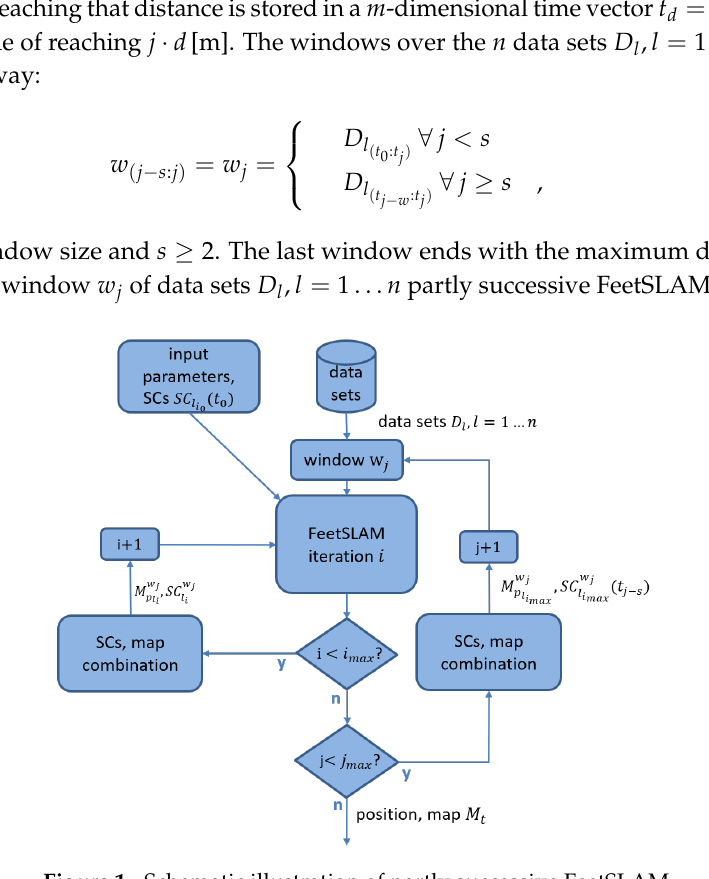
Figure 1. Schematic illustration of partly successive